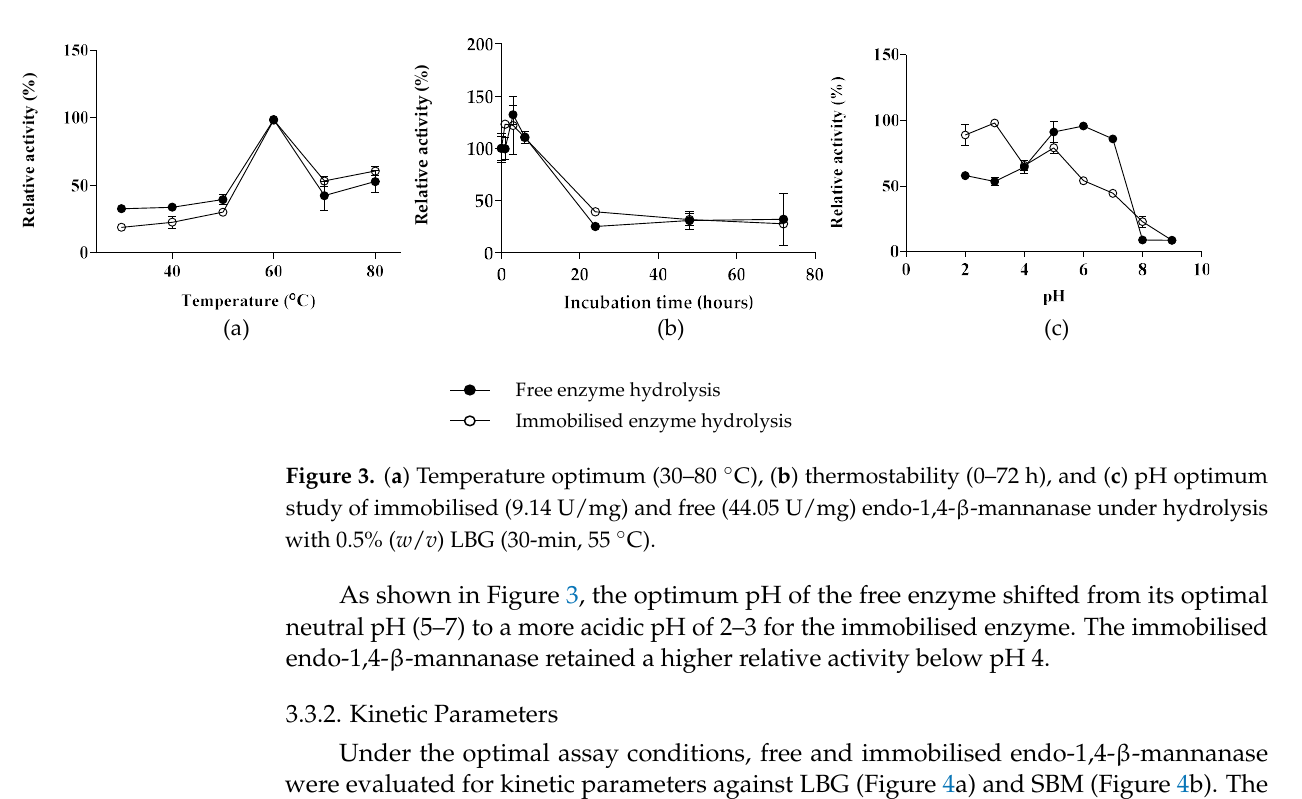
Table 1. Kinetic parameters of free and immobilised endo-1,4-β-mannanase with LBG (0.05–0.15% ( w / v )) and SBM (3.0–8.0% ( w / v )). Substrate